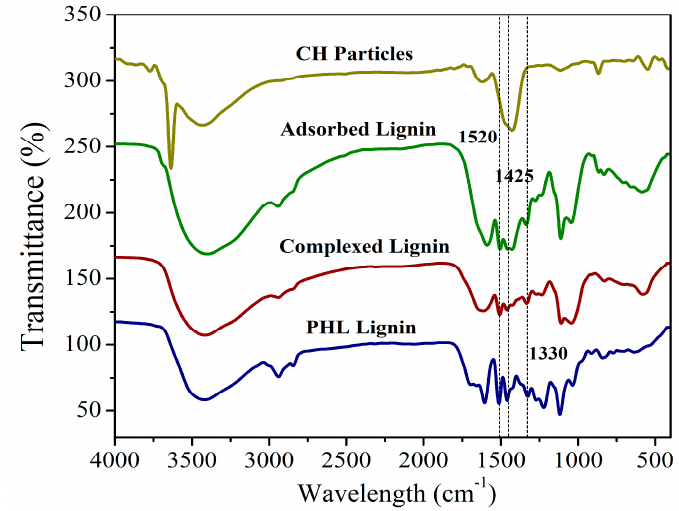
Figure 2. FTIR spectra of original CH particles, mixture of CH particles adsorbed and complexed by lignin, and original PHL lignin. Note: mixture of CH particles adsorbed lignin means the lignin adsorbed on CH particles in CH treatment process; mixture of complexed lignin means lignin precipitates obtained by CH solution treatment process; original PHL lignin means the lignin obtained by centrifugation of the original PHL.